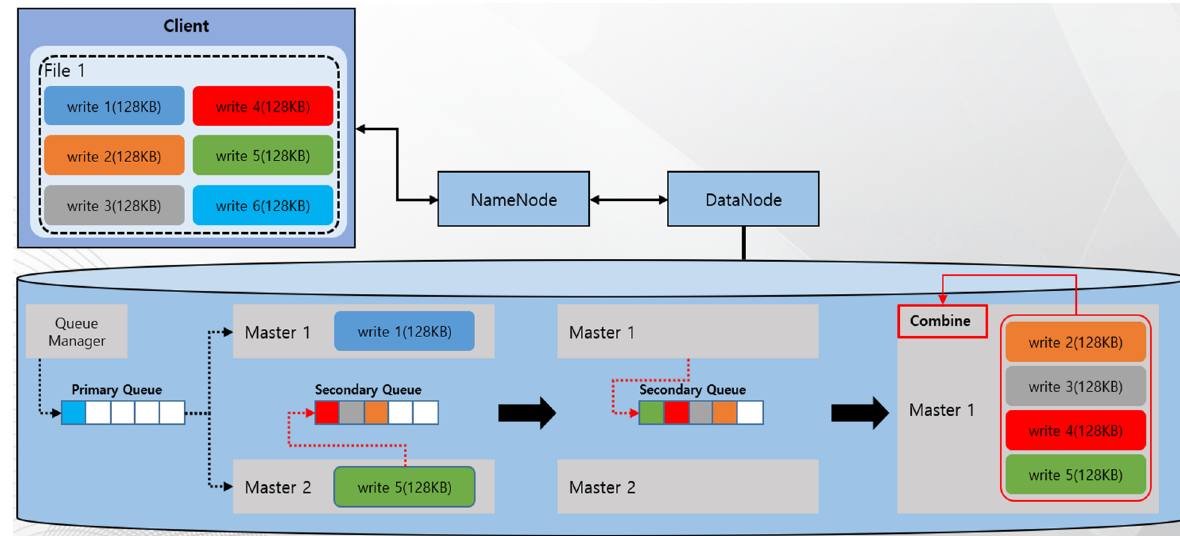
Figure 10. Method in the I/O combining step.